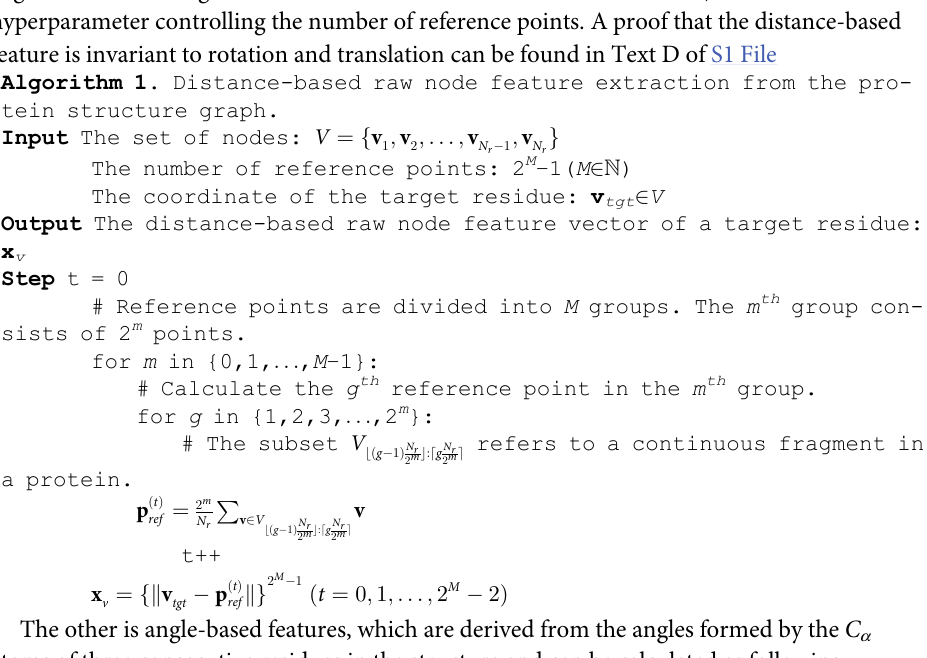
is 2 M − 1, where M is a v